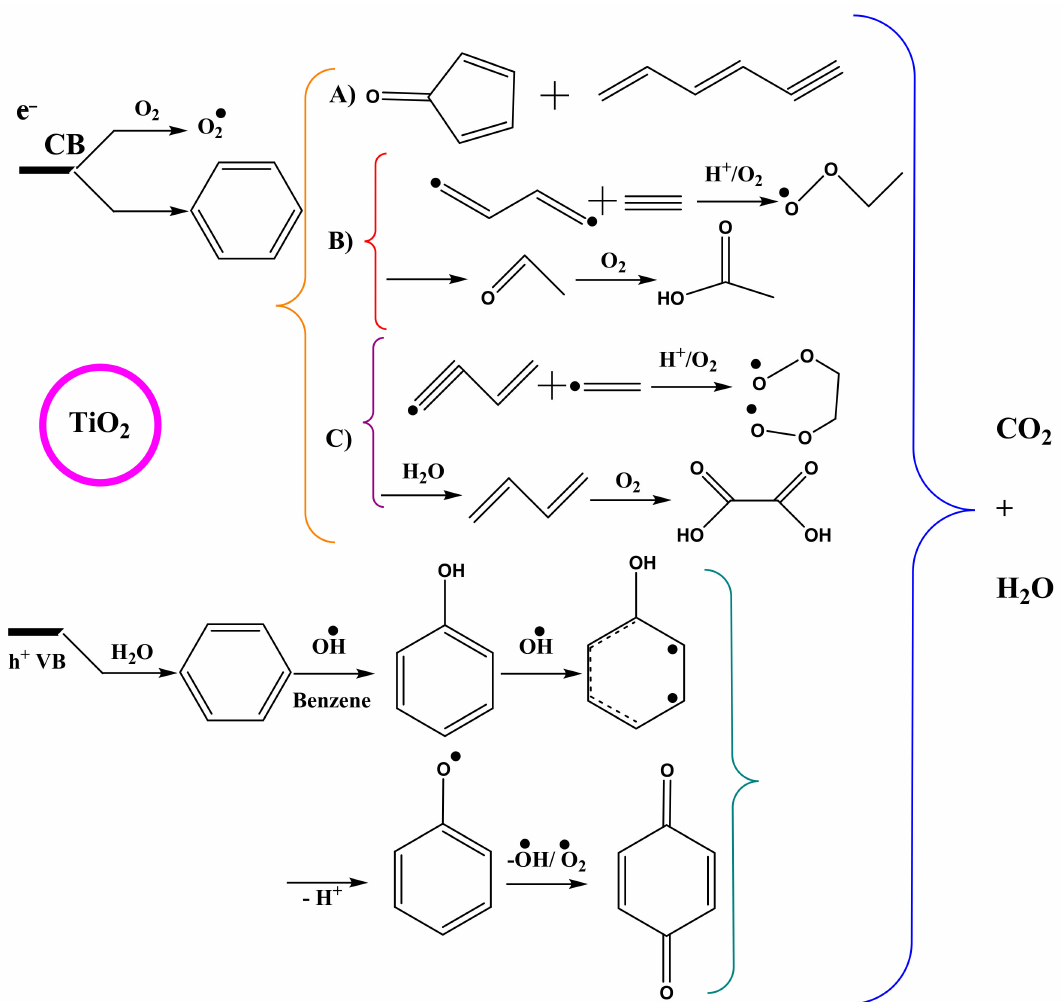
Figure 10. The mechanism of radical degradation of